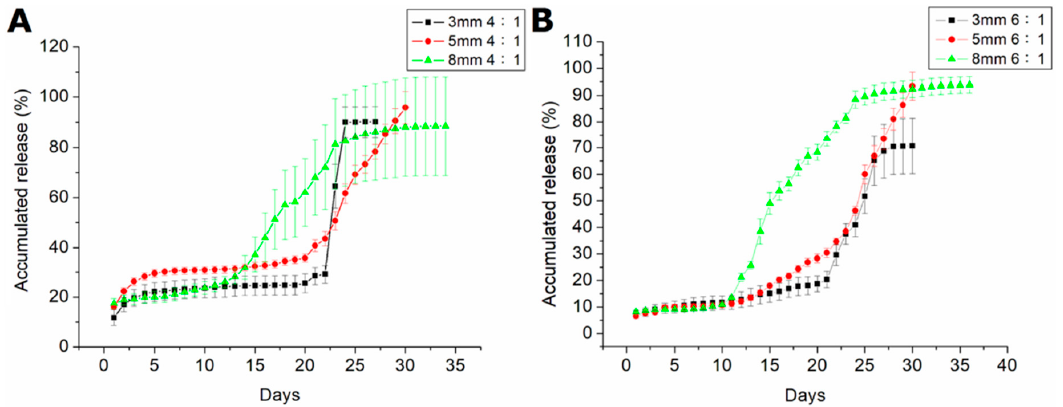
Figure 8. In vitro release curves of fluconazole from drug-loaded beads with various polymer:drug